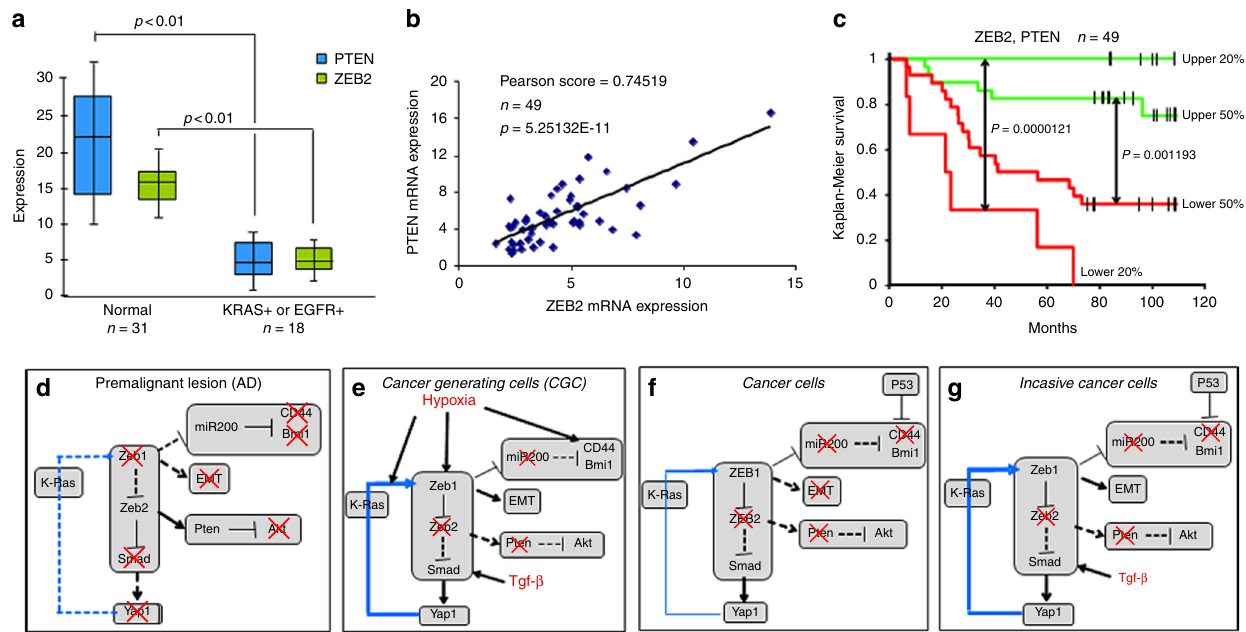
Fig. 10 A ZEB2, PTEN predicts survival in human lung AC, and model of precancerous lesion transition to lung cancer. a Box plot showing expression of ZEB2 and PTEN mRNAs in human lung AC. The top of the box is the 75 percentile, whereas the bottom is the 25 percentile. The bar indicates the median and whiskers the highest and lowest values. K-Ras + and EGFR + indicate mutations con fi rmed by sequencing, and “ Normal ” indicates adjacent uninvolved lung tissue. b Pearson plot demonstrating a linear correlation between ZEB2 and PTEN mRNA levels in tumors in a . c Survival curves showing a ZEB2, PTEN expression signature predicts survival in human lung AC. d Precancerous adenoma (AD) lesions. K-Ras mutation triggers cell proliferation leading to the outgrowth of lung epithelial cells into AAH and AD. Red “ X ” indicates a block. The blue line running through K-Ras shows that, when activated, Yap1 can bypass the ongoing requirement for K-Ras mutation in tumors 40 – 42 . Dashed lines indicate inactivated pathways, whereas solid lines show activated pathways. The font size of Zeb1, Smad, and Yap1 depict relative level of expression or activation. e Cancer-generating cells (CGC). Hypoxia and Tgf- β 1 accumulation in the interior of expanding AD triggers formation of CGC. f Cancer cells. As cancer cells form from CGC and migrate away from Tgf- β 1-rich hypoxic clusters, Zeb1 expression diminishes. This lower level of Zeb1 is suf fi cient to maintain repression of miR-200 and induction of Bmi1, and repression of Zeb2 leading to repression of Pten and nuclear Yap1. But, this lower level of Zeb1 is not suf fi cient to maintain EMT. And, CD44 is low in the cancer cells, consistent with its dominant repression by p53. g Invasive cancer. As cancer cells encounter Tgf- β 1-rich airways, Zeb1 is induced and the cells again undergo EMT. This depicts plastic EMT in cancer cells linked to invasion. But, this induction of Zeb1 in invading cancer cells does not lead to re-expression of CD44 or asymmetry of heterochromatin, Numb, and transcription factors in poles of dividing cells, as with